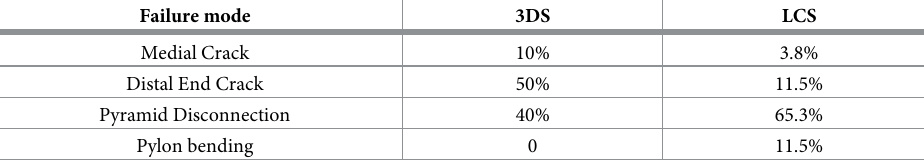
Table 5. Failure mode for 3DS and LCS after mechanical testing under Condition II and P5 loading level.